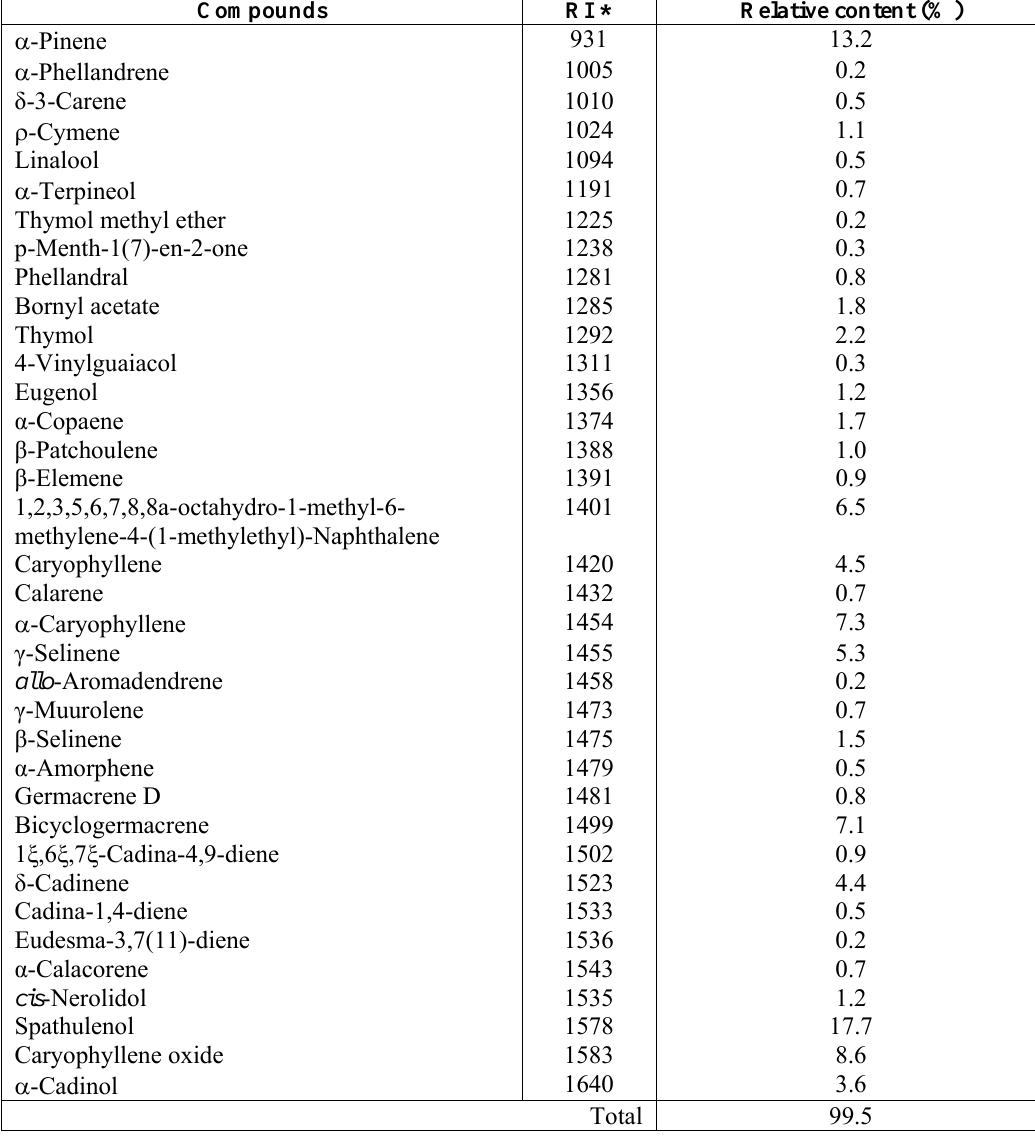
Table 1. Chemical composition of the essential oil of Murraya exotica.